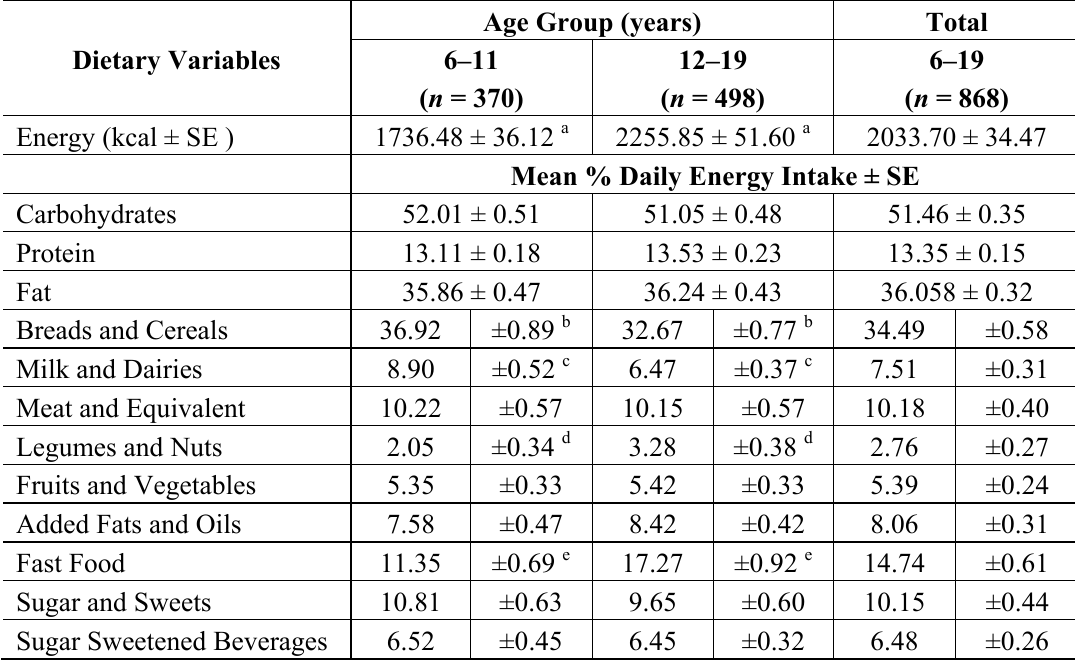
Table 3. Energy, macronutrient and food group intake amongst Lebanese children and adolescents according to age group ( n =